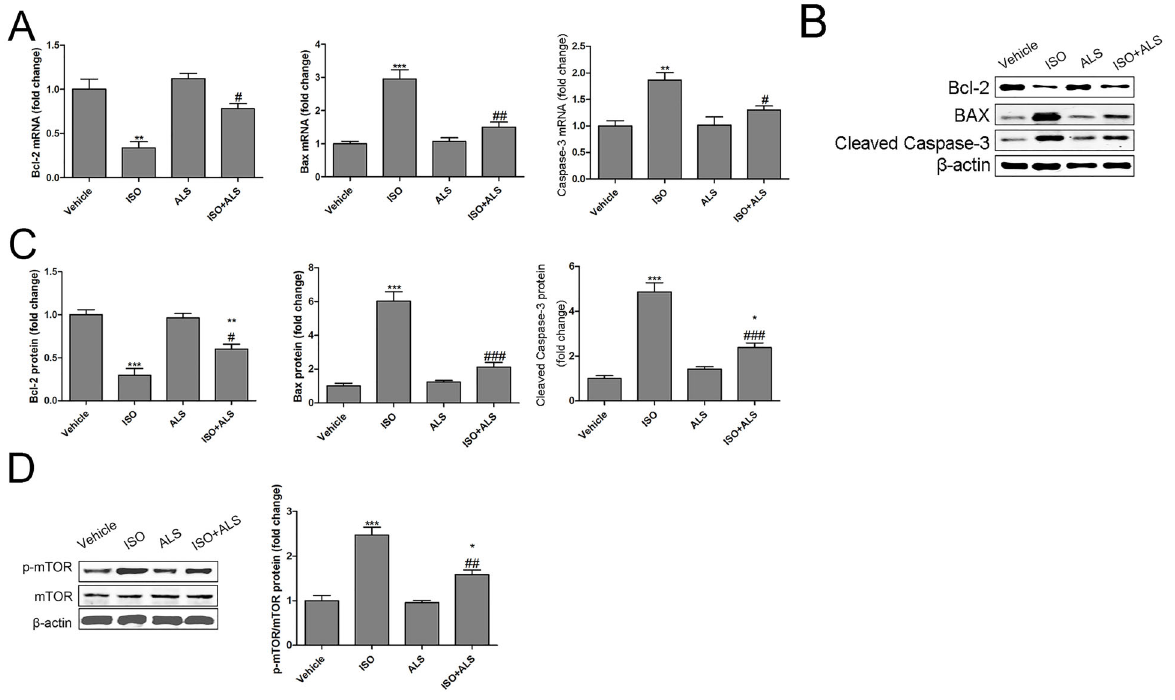
Figure 4. Aliskiren (ALS) inhibited the mTOR and apoptosis pathways in isoproterenol (ISO)-treated rats. The mRNA expression of Bcl-2, Bax, and caspase-3 was measured by RT-qPCR in the left ventricles of the rats (n=6 per group) ( A ). The protein expression of Bcl-2, Bax, and cleaved caspase-3 was measured by western blotting in the left ventricles of the rats ( B and C ). The protein expression of mTOR and p-mTOR was measured by western blotting in the left ventricles of the rats ( D ) (n=6 per group). Data are reported as means ± SE. *P o 0.05, **P o 0.01, ***P o 0.001 compared with vehicle; # P o 0.05, ## P o 0.01, ### P o 0.001 compared with the ISO group (ANOVA followed by Tukey ’ s post hoc test). mTOR: mammalian target of